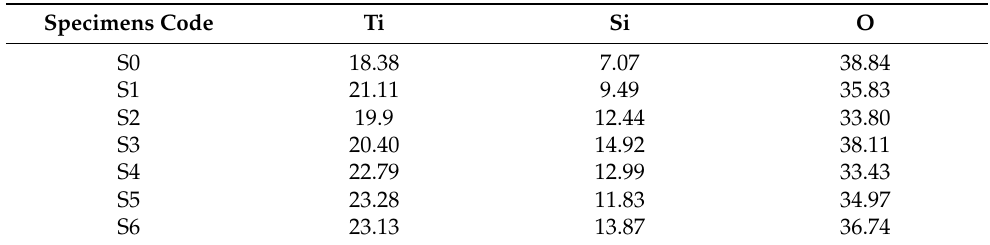
Table 2. Surface element content (wt%) of micro-arc oxidation films in different concentrations of titanium dioxide colloidal electrolytes.